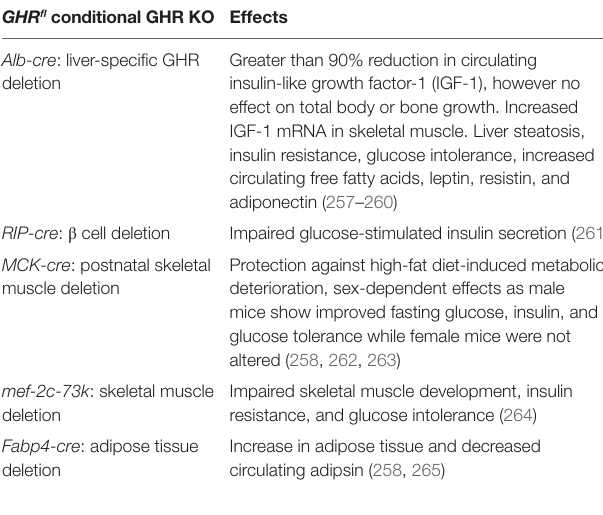
TAble 3 | Growth hormone receptor (GHR) conditional knockout (KO) mice.